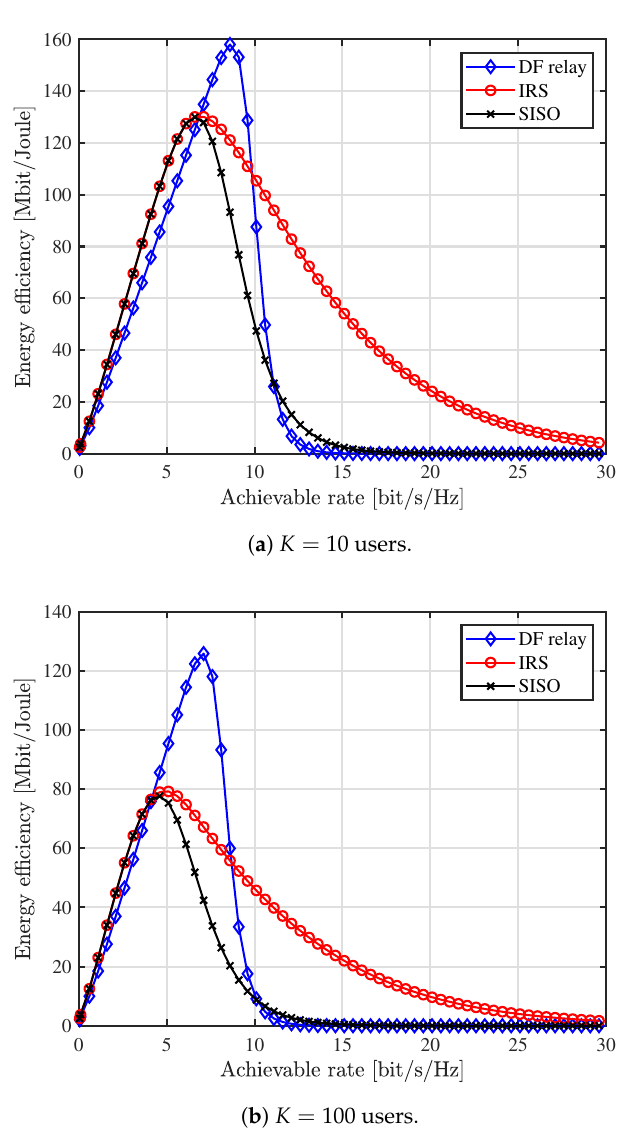
Figure 9. The energy efficiency based on the achievable rate ¯ R with a different number of users. Finally, we study the IRS performance in the case of achievable rate and energy efficiency with respect to the transmit power as shown in Figure 10. In this sim- ulation, we assign the number of users, K = 10 users, and the power dissipation in each elements of IRS as P e = 5 mW. We set a different defined number of IRS elements instead of the optimal number of elements that we applied in Figure 9. From Figure 10a, it is known that the achievable rate of IRS will be enhanced as long as the number of IRS elements and the transmit power increase as we obtained based on Equation (6). Figure 10b indicates that the IRS with the lowest number of elements attained the highest energy efficiency. The higher number of IRS elements increased the power dissipation in each element as defined in Equation (20), and thus the energy efficiency